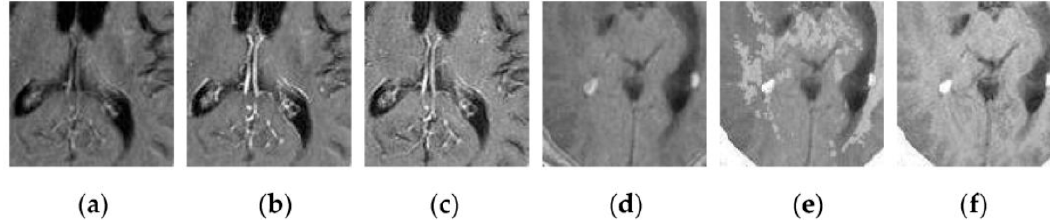
Figure 12. Enlarged views of fused results of ROIs denoted by the red boxes in Group 6 in Figure 6 for the seven methods: ( a ) the DWT method; ( b ) the NSCT method; ( c ) the NSCT-SR method; ( d ) the m-PCNN method; ( e ) the PCNN-NSCT method; ( f ) the SCM-F method; and ( g ) the SCM-M method.